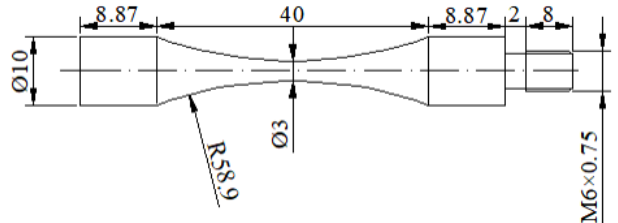
Figure 1. Geometries and dimensions of the test